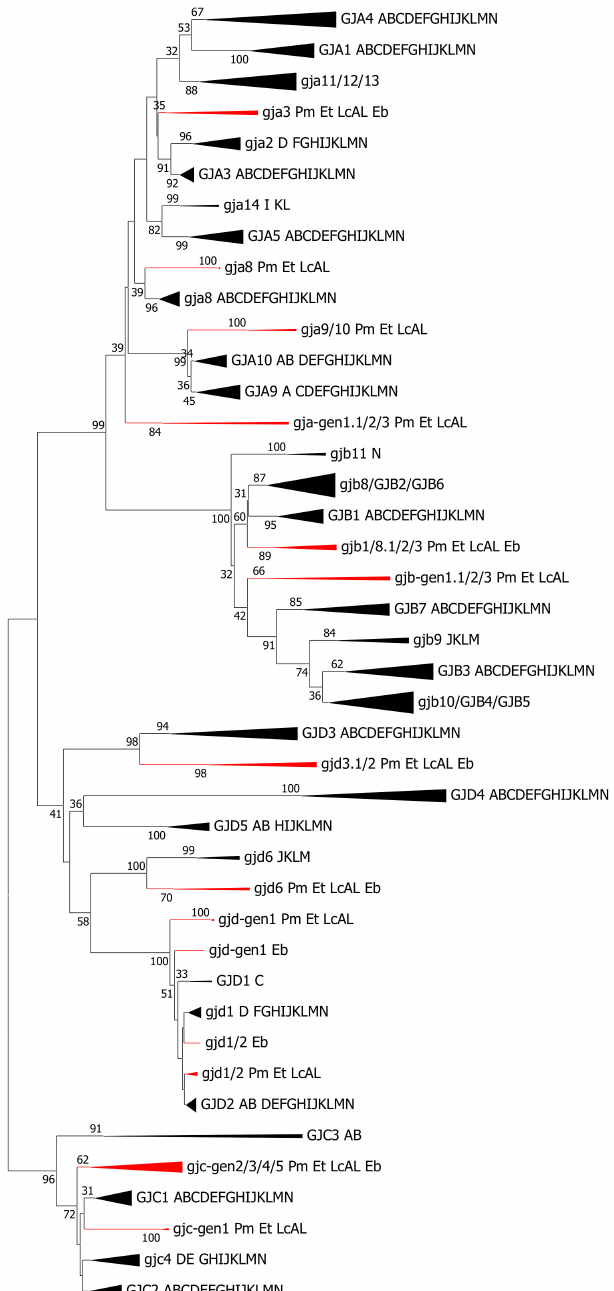
Figure 3. Compressed phylogenetic tree for connexins, except GJE1 , in cyclostomes and gnathostomes. The annotation for the vertebrates is as described in the legend of Figure 2. The cyclostome sequences are indicated with their preliminary gene name (defined as described in the text) followed by the abbreviation describing the cyclostome species: Pm, Petromyzon marinus , sea lamprey; Et, Entosphenus tridentatus , Pacific lamprey; LcAL, Lethentheron camtschaticum , Arctic lamprey and Eb, Eptatretus burgeri , inshore hagfish. The cyclostome branches are indicated in red. The tree was constructed on the basis of the amino acid sequence (205 positions and 635 sequences) of the conserved domains by the Neighbor-Joining method using the JTT substitution matrix and with the rate variations among sites corresponding to a gamma value = 1.1 (same as in Figure 2) and with bootstrap statistics (500 iterations). Bootstrap values below 30 are not shown. Some of the orthogroups were united to save space and for giving a better overview. A Neighbor-Joining tree including GJE1 , using the same JTT substitution matrix but with a gamma parameter = 0.8, is shown in Supplementary Figure